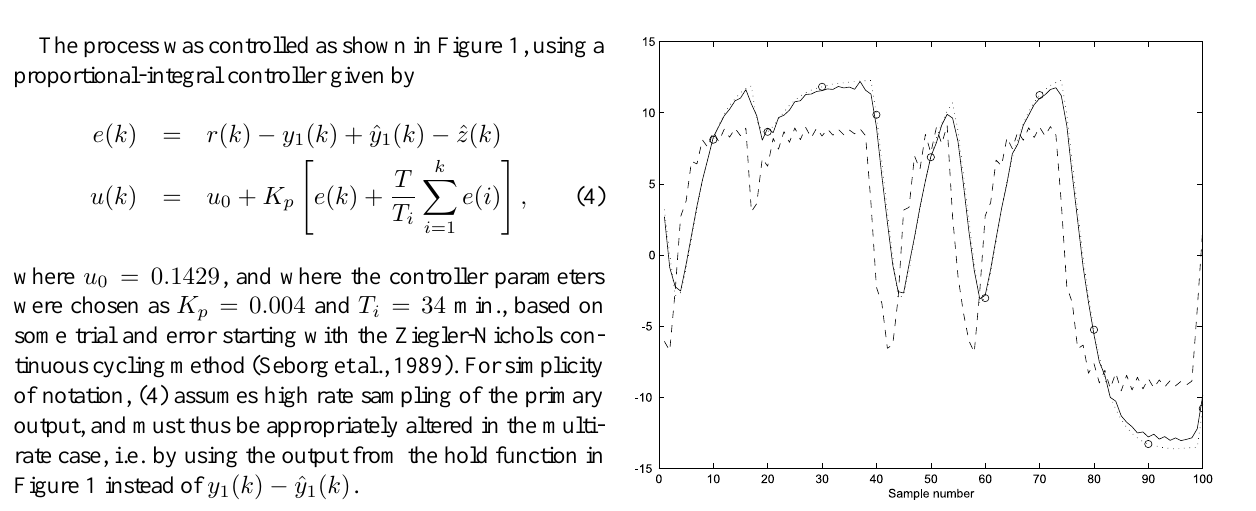
Figure 3: Segment of y 1 ( k ) validation responses (centered data) for initial ARMAX+LS estimator (dashed line) and final OE estimator (solid line) in the multirate identification case. The ideal response is shown by dotted line with o-markings at the j sampling